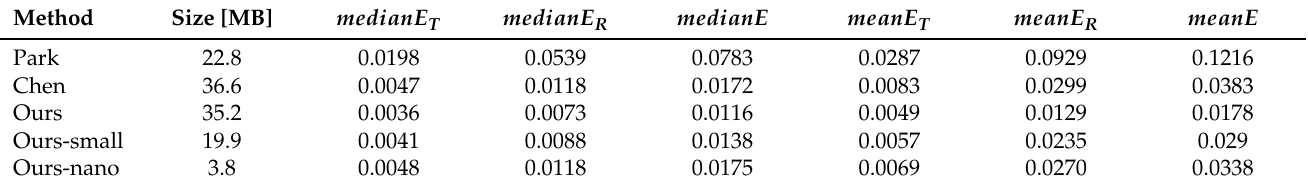
Table 1. The performance of three methods on 1000 synthetic images. Ours-small means that we reduce the size of the feature maps by 25%. Ours-nano means that we reduce the size of the feature maps by 50%.